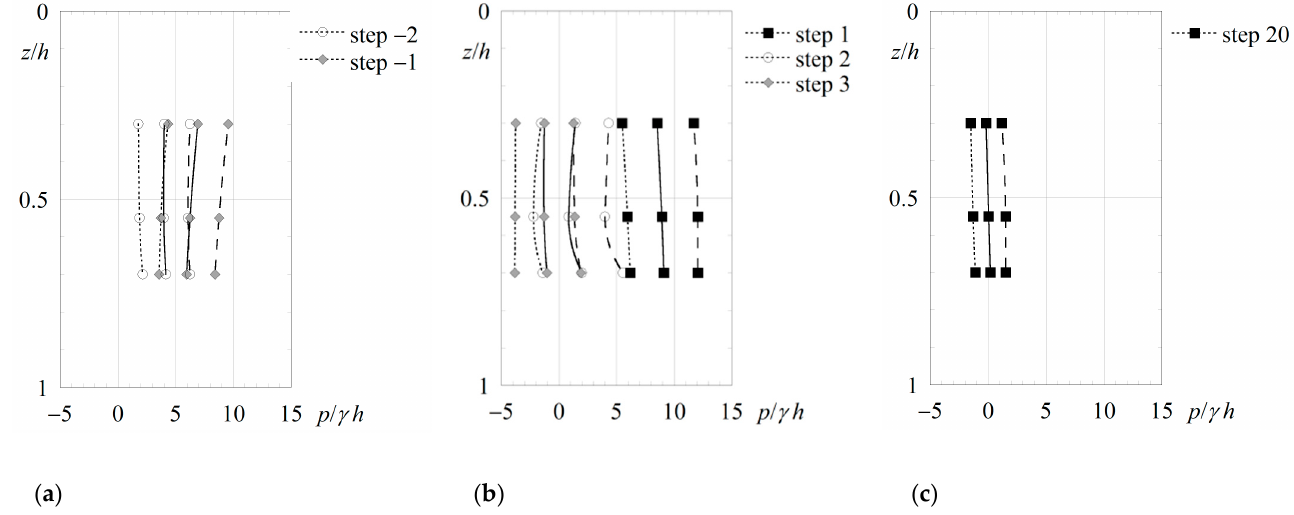
Figure 9. Dimensionless pressures p /( γ h ) on the vertical step faces for the 50 ◦ to 18.6 ◦ slope reduction and d c / h = 4.6: ( a ) upstream of the slope reduction, ( b ) just downstream, and ( c ) “far” downstream; ( ··· ) 5th percentile, (—) mean, and (---) 95th percentile.